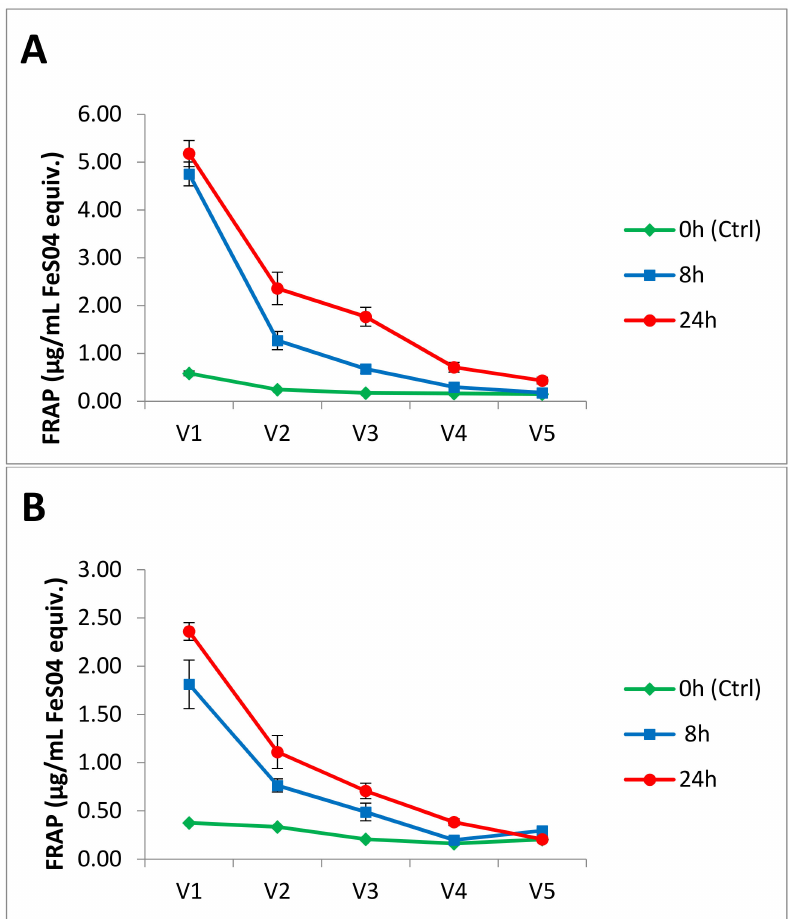
Figure 2. Time course of antioxidant capacity ferric reducing antioxidant power measures of